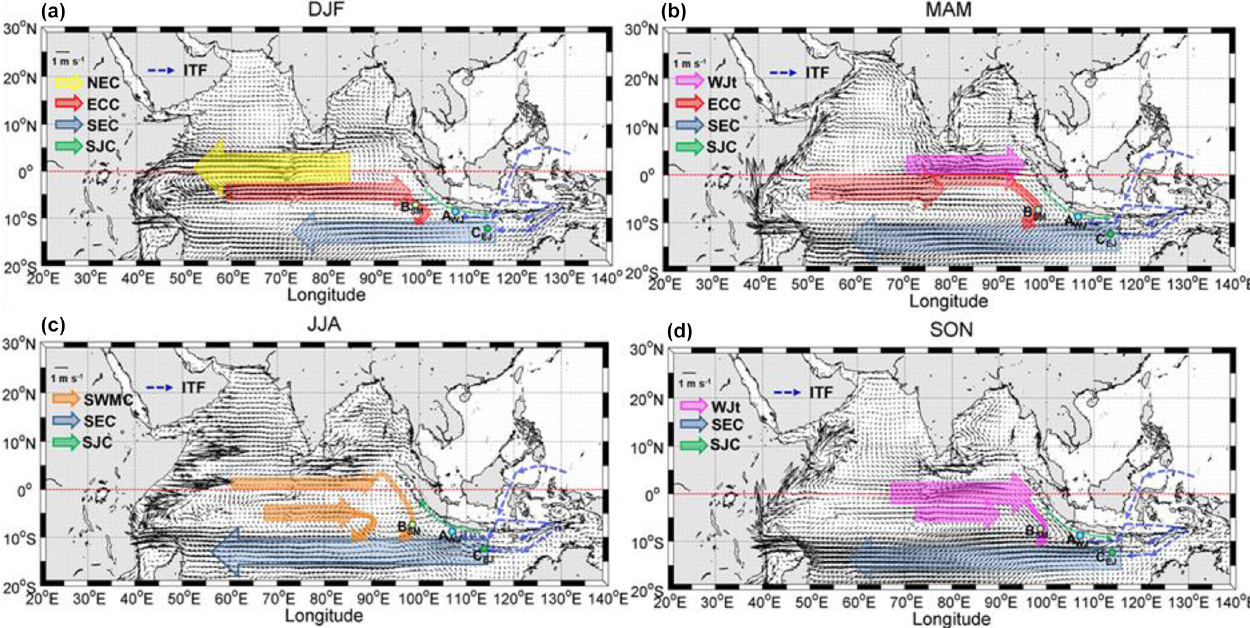
Figure 8. Seasonal averaged surface (1m) currents over 64 years (1950–2013) and schematics of the tropical current systems in the Indian Ocean during (a) DJF, (b) MAM, (c) JJA, and (d) SON. Current branches indicated by coloured arrows (not black) are the North Equatorial Current (NEC), Equatorial Counter Current (ECC), South Equatorial Current (SEC), South Java Current (SJC), Wyrtki Jet (WJt), Southwest Monsoon Current (SWMC), and Indonesian Throughflow (ITF). The dashed line represents the thermocline